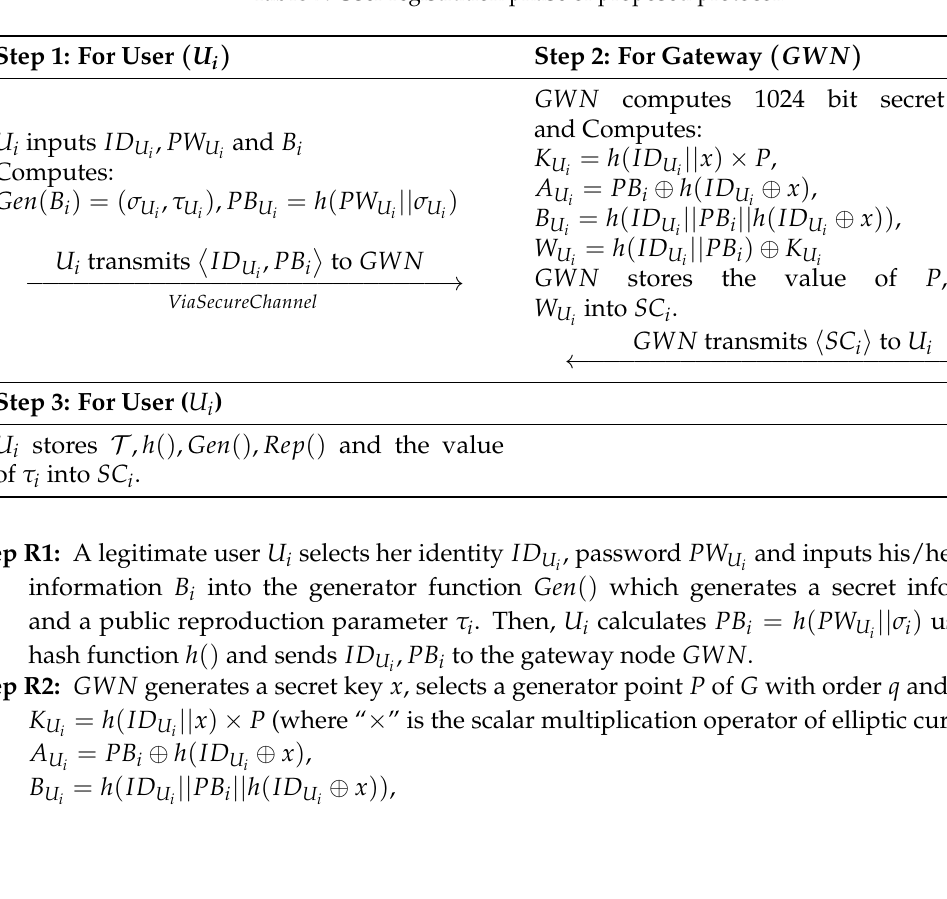
Table 7. User registration phase of proposed